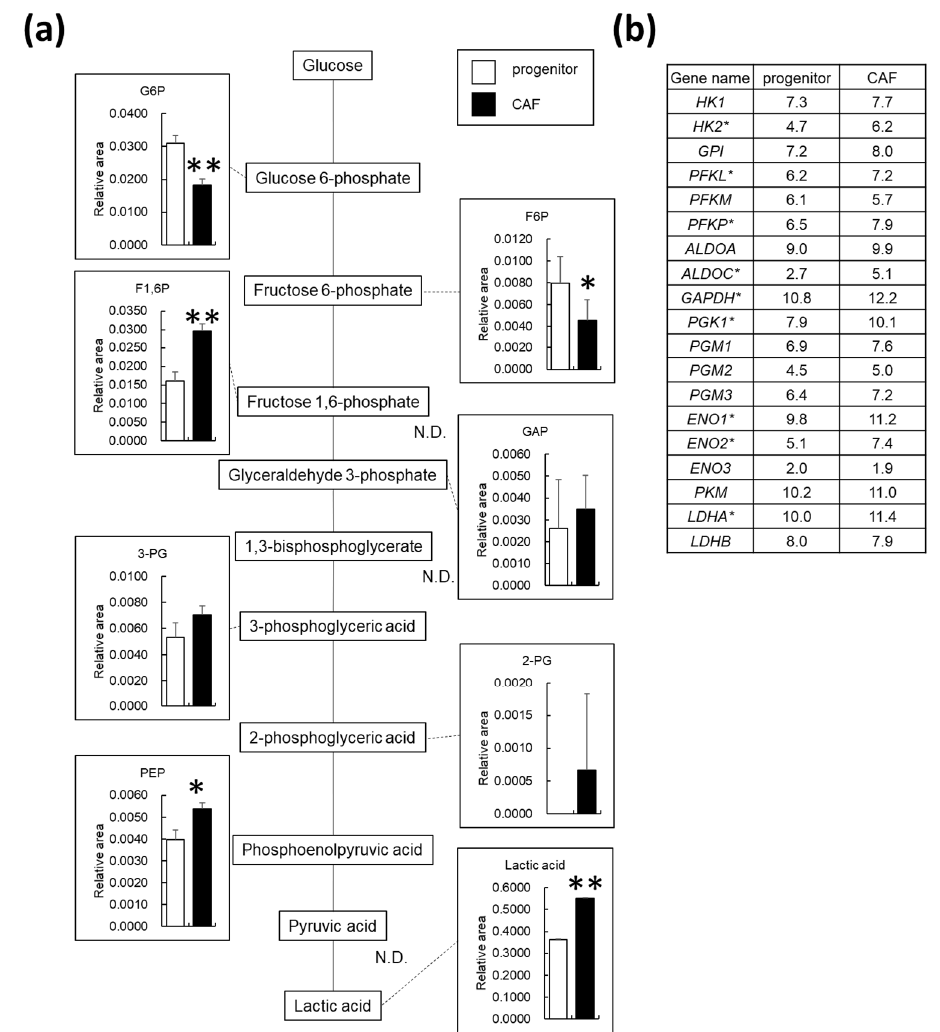
Figure 3. Changes in metabolites involved in glucose metabolism in the cancer-associated fibroblast (CAF) progenitors and CAFs: ( a ) Graphical representation of relative metabolite changes between CAF progenitors and CAFs as determined by capillary electrophoresis time-of-flight mass spectrometry. N.D. indicates not detected. ** p < 0.01, * p < 0.05; ( b ) List of genes involved in glycolysis and their expression levels in CAF progenitors and CAFs. Log2 normalized counts per million values. Asterisks (*) indicate differentially expressed genes.